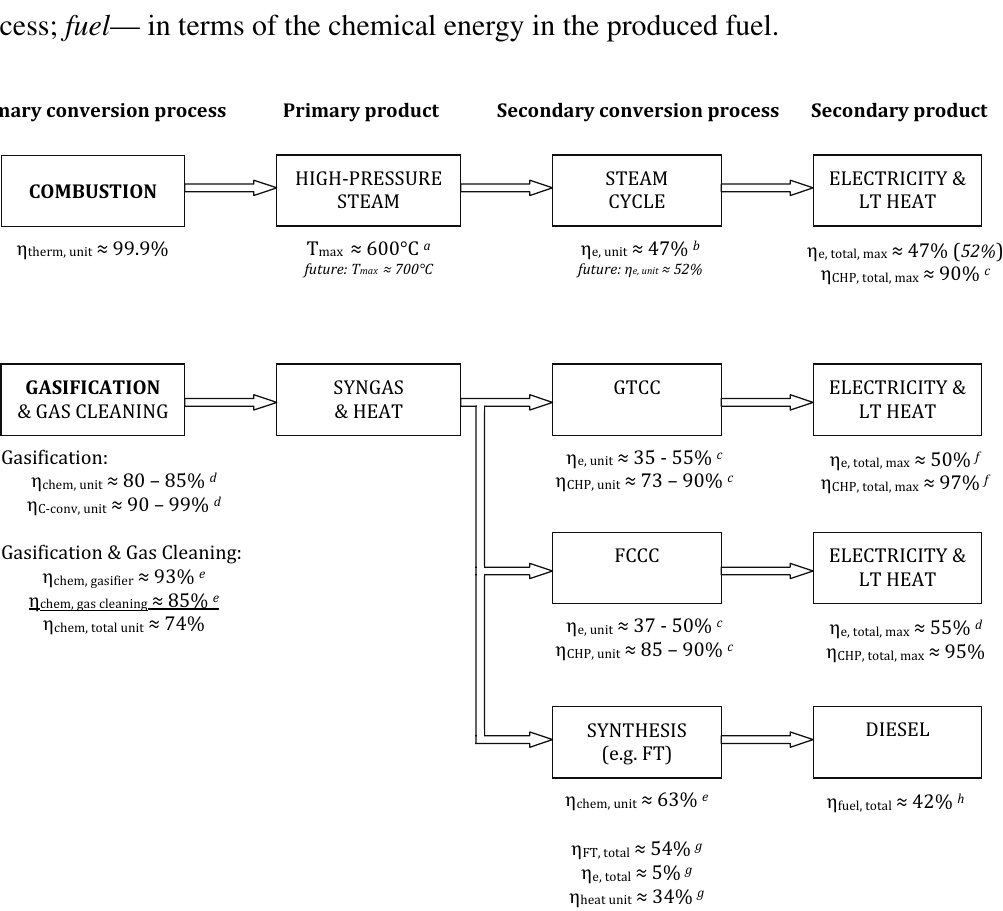
Figure 5 . Comparison of the solid fuel combustion and gasification processes in terms